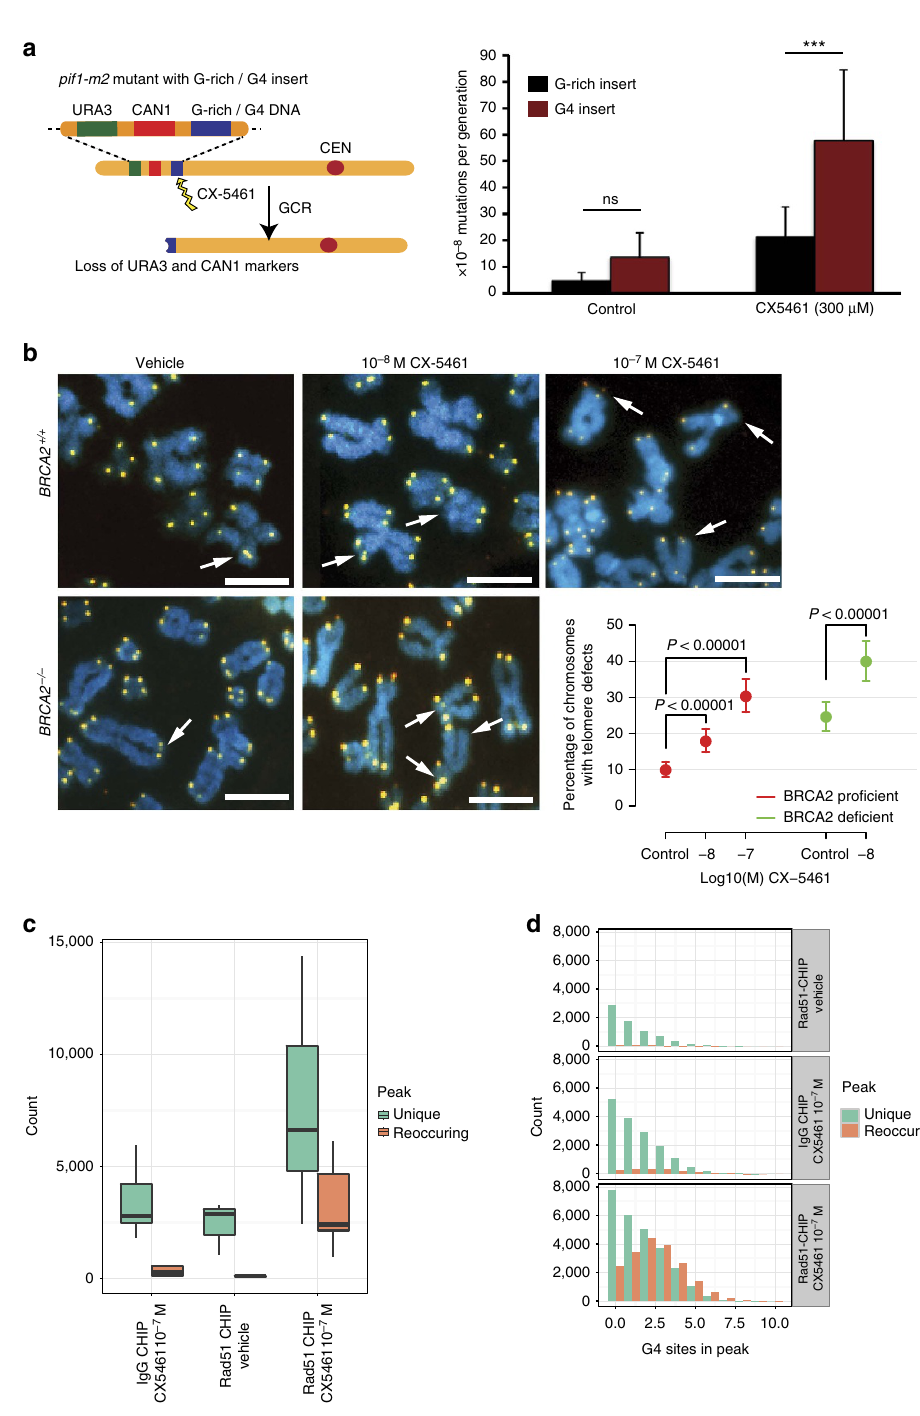
Figure 6 | CX-5461 induces chromosome instability at G4 sequences in human and yeast systems. ( a ) The CX-5461 induces increased GCR rates in yeast. Left panel shows the GCR assay setup. Right panel shows increased GCR rates induced by CX-5461 compared to untreated control and to a non-G4 forming G-rich control sequence (represented as per 10 (cid:2) 8 mutations/generation). N ¼ 3. ( b ) Effect of CX-5461 on telomere fragility in BRCA2 þ / þ and BRCA2 (cid:2) / (cid:2) HCT116 cells. Arrows point to telomere defects with either fragile telomeres or missing telomeres. N ¼ 3, 4 100 cells each replica. The data were modelled using a logistic regression model. Scale bar, 5 m M. ( c ) RAD51-ChIP after CX-5461 treatment identified more peaks than with vehicle control and IgG-CHIP in U2OS cells. Three biological replicates per condition and two for IgG backgrounds. Peaks were classified as unique if occurred in isolation, or reoccurring if overlapped with at least one other peaks ± 500bp. Error bars depict the range of peak numbers for three biological replicates. The exact peak numbers are shown in Supplementary Tables 8 and 9. ( d ) Peaks identified from RAD51-ChIP with CX-5461 treatment enrich for G4 sites. The number of G4 sites in unique and reoccurring peaks are shown for three ChIP conditions. G4 sites normalized by peak length are shown in Supplementary Fig. 6d. Peak length distribution is shown in Supplementary Fig. 6e. A screen shot of the peak is shown in Supplementary Fig.